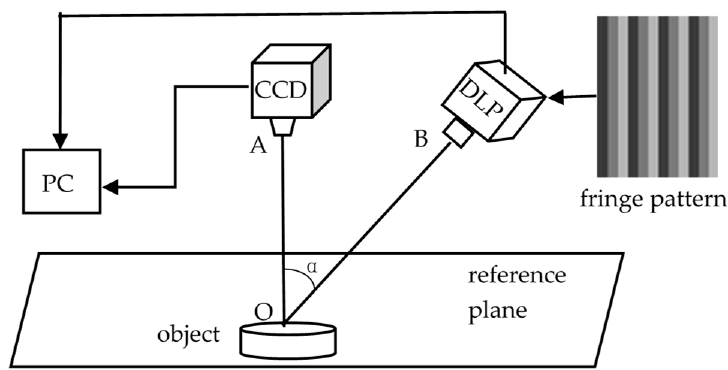
The schematic diagram of a real-time 3D measuring method based on single-shot quaternary grating projection is shown in Figure 3. The quaternary grating is encoded and saved into the flash memory of the (Digital Light Processing) DLP. The DLP projects the quaternary grating with the period width of 9 pixels onto the reference plane and the object, and the project angle α is 27 degrees. At the same time, a high frame rate monochrome Charge-coupled Device (CCD) camera is capturing the corresponding fringe pattern synchronously on the same plane.